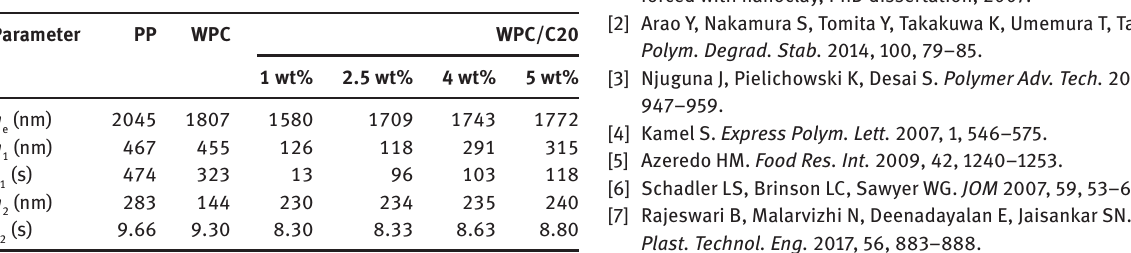
Table 3: Fitting parameters from Equation (4) for polypropylene, WPC and WPC/C20 from the indentation creep